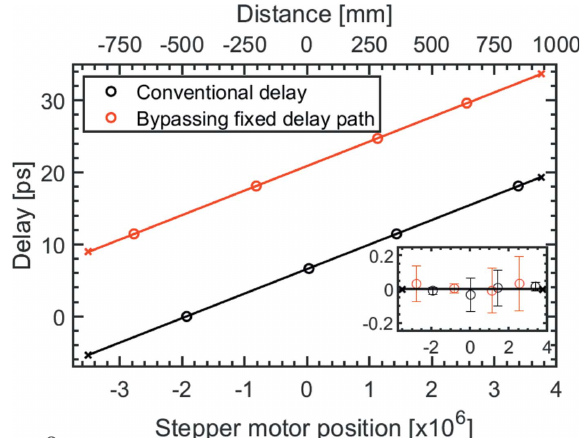
Figure 8 Linearity of the delay stage as measured by a laser with reduced coherence time. The black circles refer to an interference of the two beams in the fixed delay path and variable delay path. The red circles refer to the measured interferences between the beam of the variable delay path and a beam passing directly through the SDU. The additional delay obtained by bypassing the fixed delay path amounts to 14.3 ps. The covered delay range of the SDU spans between the crossed markers, allowing delays between (cid:3) 5 ps and 18 ps with the conventional set-up and up to 32 ps when bypassing the fixed delay path. The fit results in a slope of (2.95 (cid:4) 0.02) (cid:6) 10 5 steps of the stepper motor for 1 ps. In the inset the residuals of the slopes are shown, which amounts to 6 fs. The error is given by the coherence length of the individual coherence